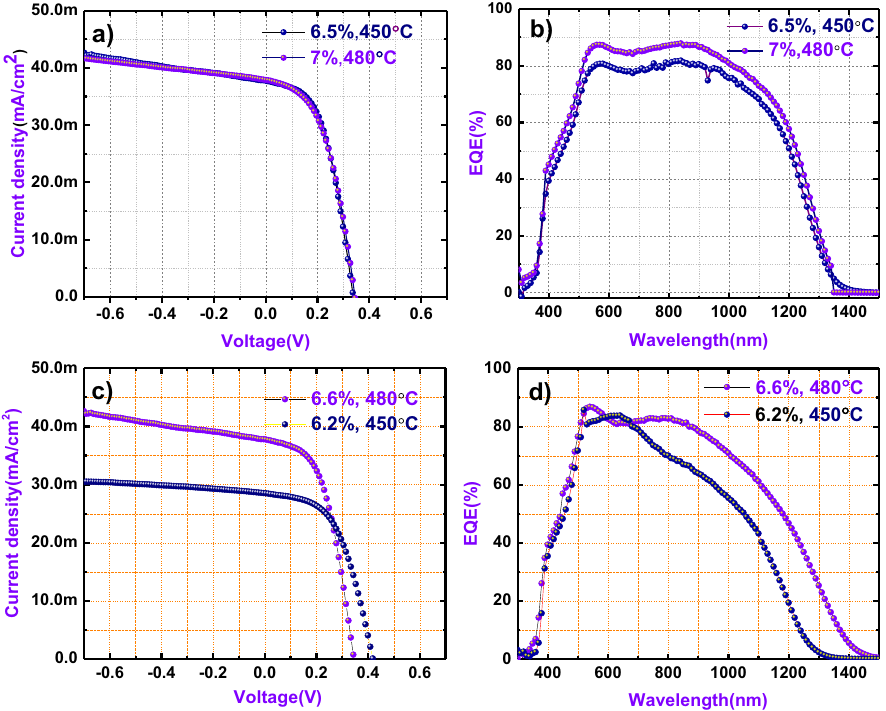
Fig. 7. (a) and (c) Illuminated IV curves of CZTSe solar cells with a [Cu]/[Zn] + [Sn] ratio of 0.84 and 0.76 selenized at 450 ◦ C and 480 ◦ C repsectively (b) and (d). External Quantum efficiency curves of CZTSe solar cells with a Cu]/[Zn] + [Sn] ratio of 0.84 and 0.76 selenized at 450 ◦ C and 480 ◦ C